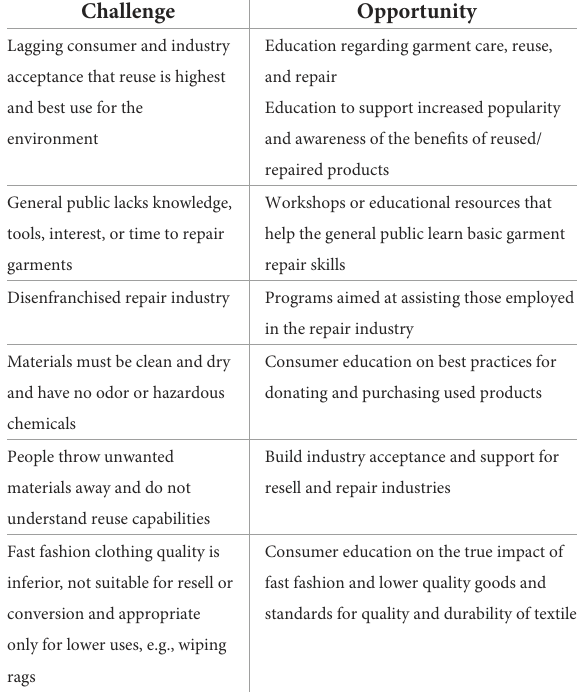
TABLE 2 Challenges and opportunities for textiles reuse and repair (Schumacher and Forster,